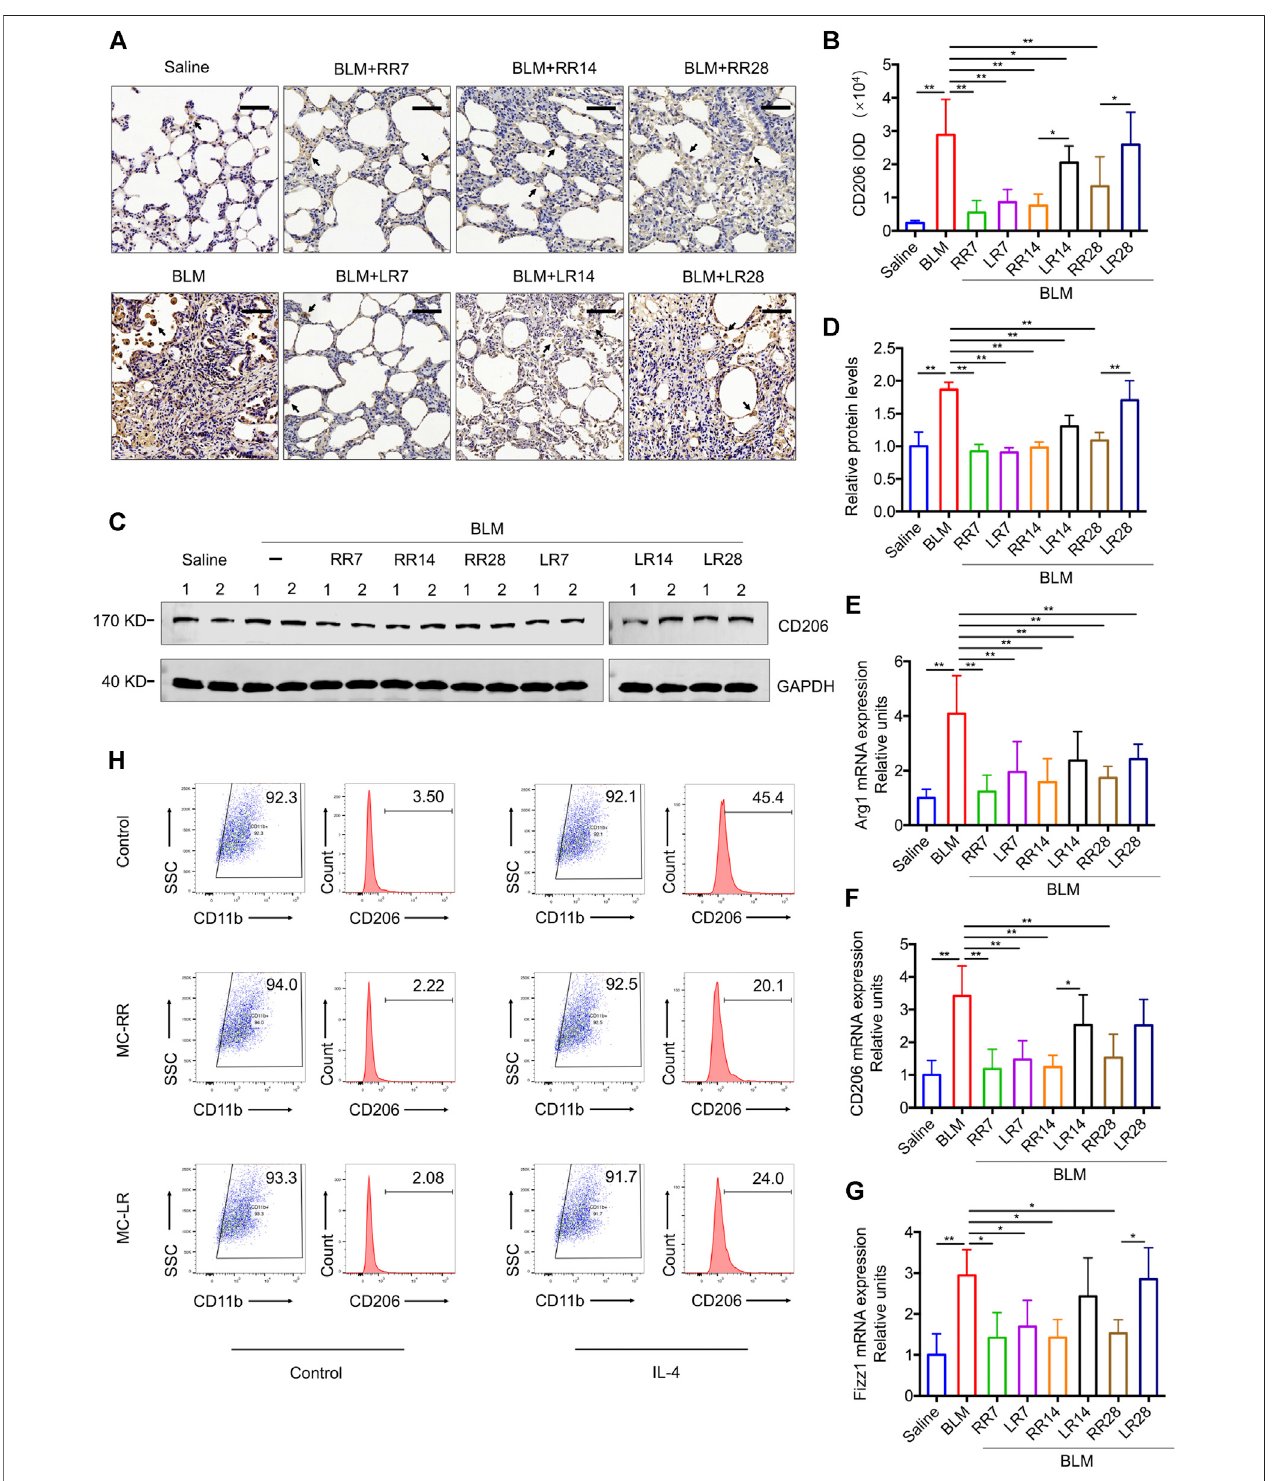
FIGURE 5 | Microcystin-RR (MC-RR) suppresses the expression of M2 macrophage-related markers. (A – G) Rats were treated as explained in Figure 3 . (A,B) Representativeimmunohistochemicalstainingandquanti fi cationofCD206intheratlungtissuesections.Scalebar:100 μ m.BlackarrowsindicateCD206-positivecells. (C,D) The protein level of CD206 in rat lung tissues was measured by western blotting and quanti fi ed. (E – G) The mRNA expression of arginase-1 ( Arg1 ), CD206 , and resistin-like molecule- α ( Fizz1 ) in rat pulmonary tissues was examined by quantitative Reverse-Transcription Quantitative Polymerase Chain Reaction (RT-PCR). Data are presented as mean ± SD. * p < 0.05, ** p < 0.01 determined by one-way ANOVA with S-N-K post-hoc analysis. Each group had fi ve rats. (H) RAW264.7 cells were left alone or treated with interleukin (IL)-4 (5 ng/ml) for 48 h to induce polarization. In some of the assays, cells were also treated with 0.1 μ M MC-RR or MC-LR for the same duration as indicated. Percentages of M2-like macrophages (CD206 + /CD11b + ) were analyzed by fl ow cytometry.